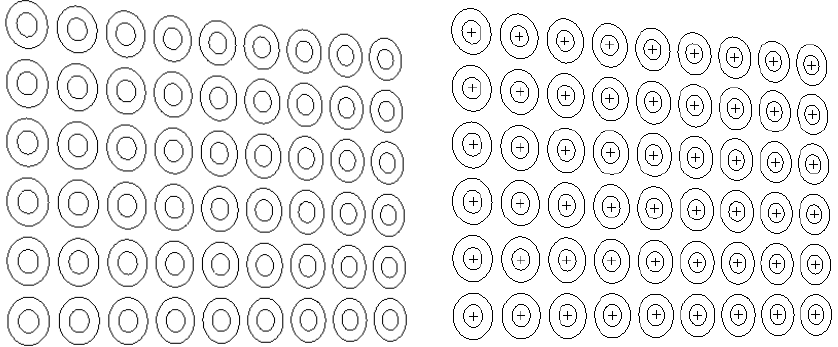
Figure 11. The corresponding calibration points ( Left ) Binarized image; ( Right ) Calibration points (Black cross line).